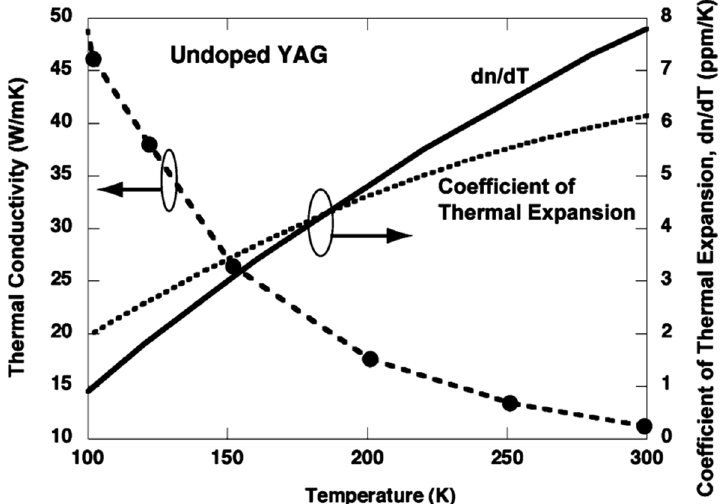
Figure 1. Thermal conductivity, thermo-optic coefficient, and thermal expansion coefficient of YAG crystal as a function of temperature [10]. Reprinted/adapted with permission from Ref. [IEEE]. 2007, Tso Yee